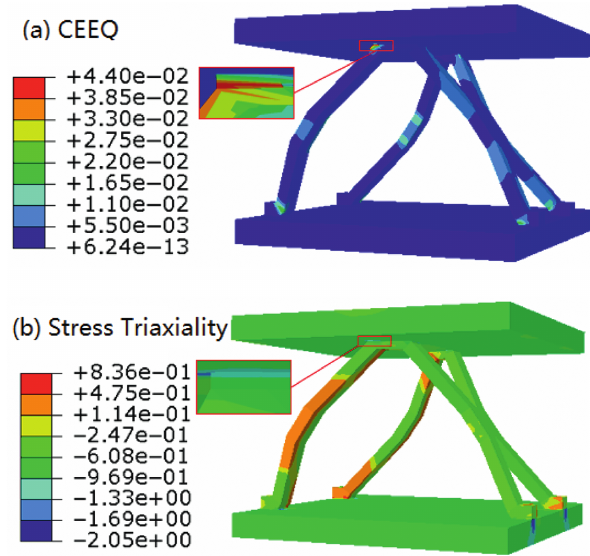
Figure 8: Contours of CEEQ (a) and stress triaxiality (b) at compression load.